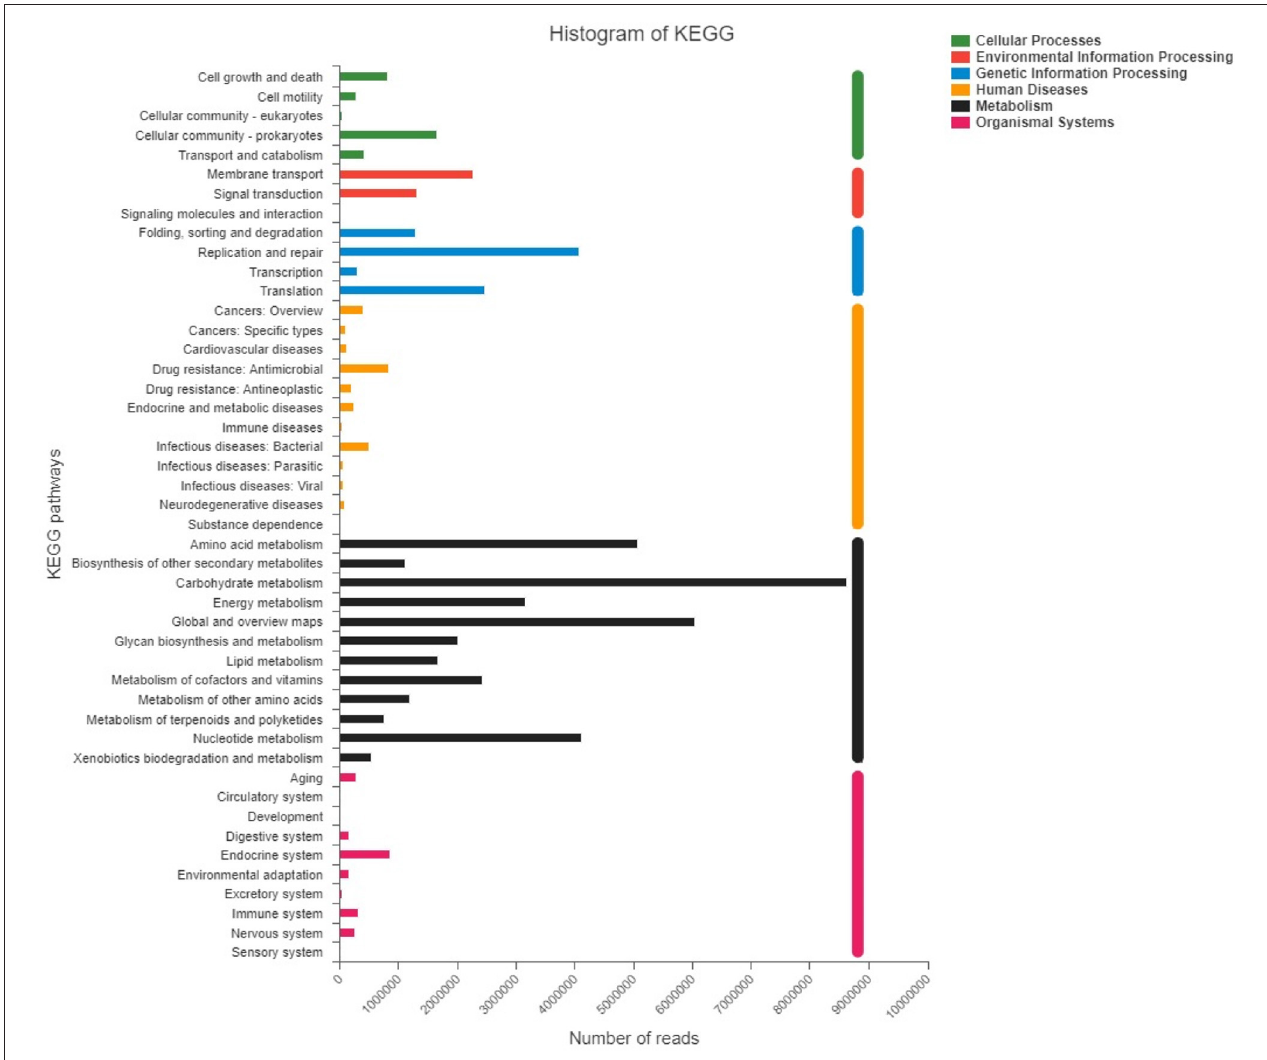
FIGURE 12 | KEGG pathways at Levels 1 and 2 found in FATPHs and PATPHs. E ≤ 1e −